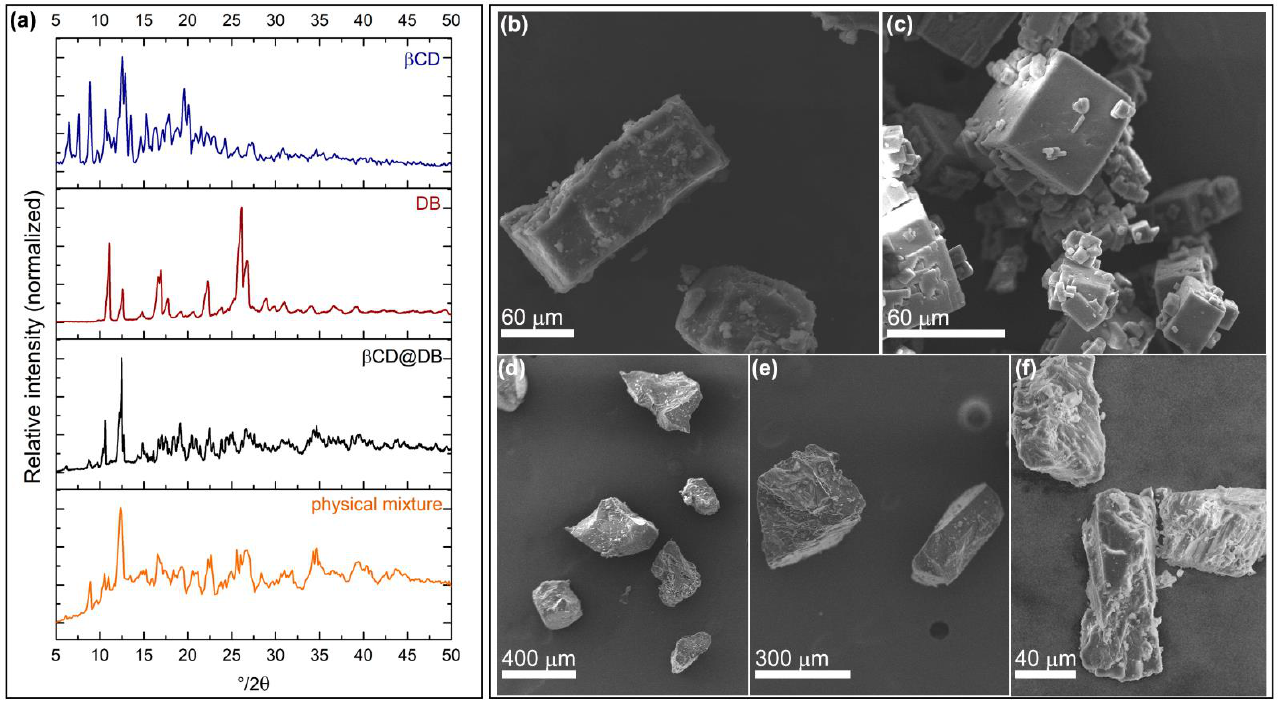
Figure 2. Powder X- ray diffractogram of crystalline powder of βCD, DB, βCD@DB , and βCD -DB Figure 2. Powder X-ray diffractogram of crystalline powder of β CD, DB, β CD@DB, and β CD-DB physical mixture ( a ). SEM micrograph of βCD ( b ), DB ( c ), βCD@DB ( d , e ), and FE-SEM micrography physical mixture ( a ). SEM micrograph of β CD ( b ), DB ( c ), β CD@DB ( d , e ), and FE-SEM micrography of βCD@DB ( f ). of β CD@DB ( f